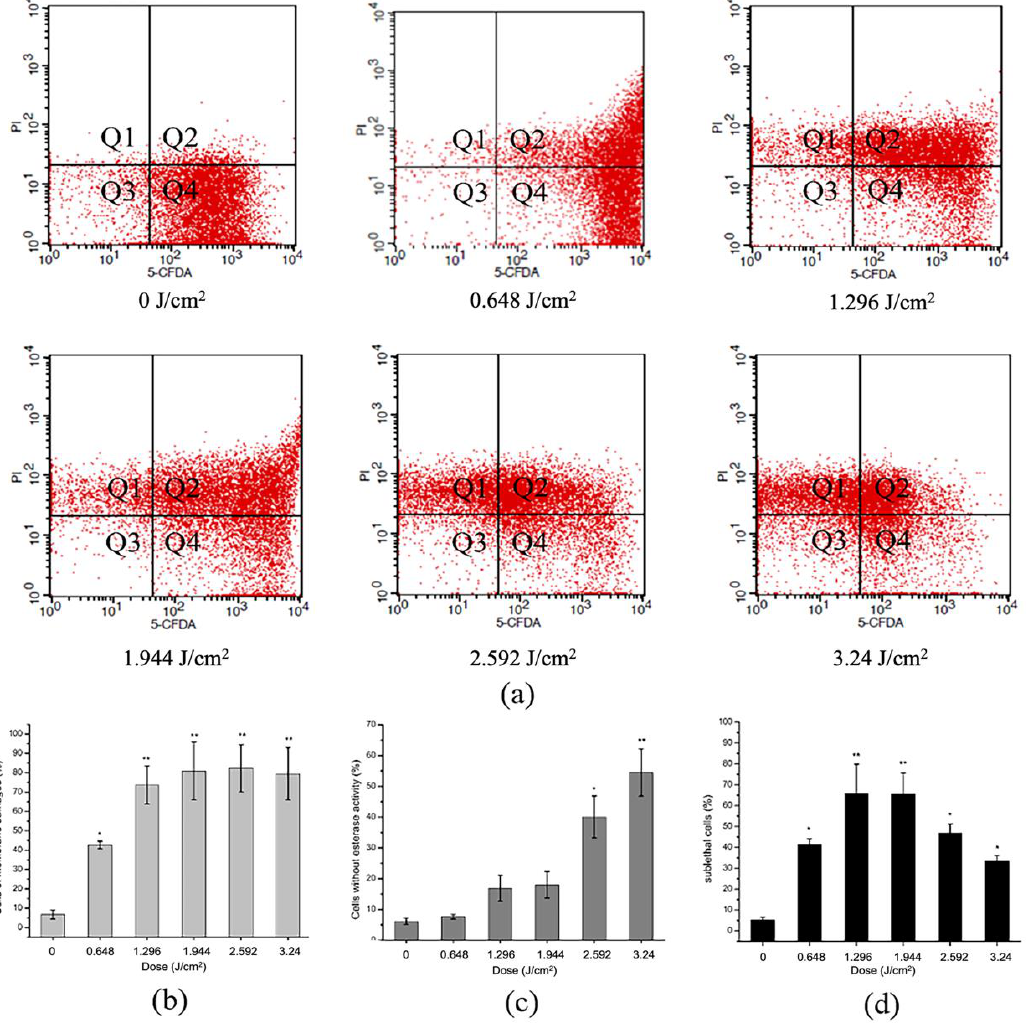
Figure 5. ( a ) Effect of aPDT against S. aureus with different light dose (0, 0.648, 1.296, 1.944, 2.592, 3.24 J/cm 2 ), which membrane integrity and esterase activity indicated by flow cytometry with cFDA and PI; ( b ) showed the proportion of membrane damaged cells; ( c ) showed esterase activity lost cells; and ( d ) sublethal cells in the flow cytometry investigation. Bars with an asterisk indicate significant difference ( p < 0.05) compared to the control group. The more asterisks, the stronger the significance.